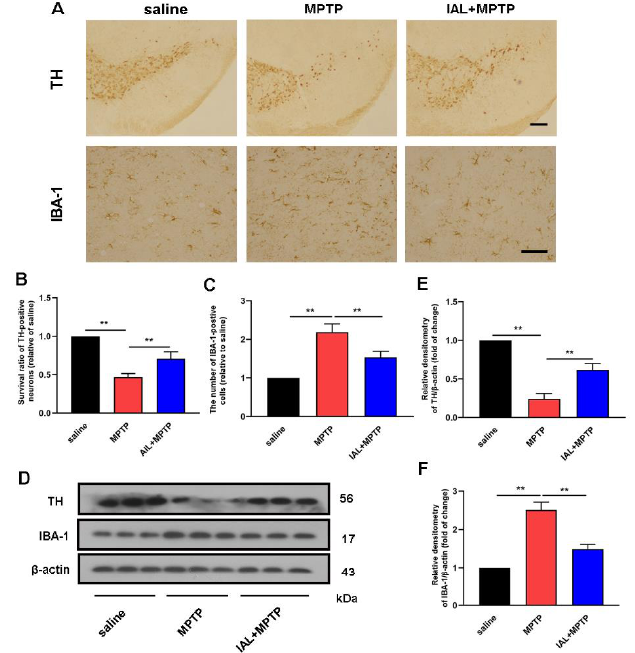
Figure 2. IAL decreases dopaminergic neuron degeneration and inhibits microglia over-activation in MPTP-induced PD mice. ( A , B ) The number of TH-positive cells in the SN was detected using the immunohistochemistry method (the bar is 50 μm). ( A , C ) The number of microglia in the SN was marked with IBA-1 using an immunohistochemistry method (the bar is 20 μm). ( D − F ) The proteins of TH and IBA-1 were detected using the Western blot method. Results are presented as means ± SEM (n = 3). In the figure, black is the control group, red is the MPTP group, and blue is the MPTP+IAL treatment group. ** p < 0.01 stands for biologically significant difference.